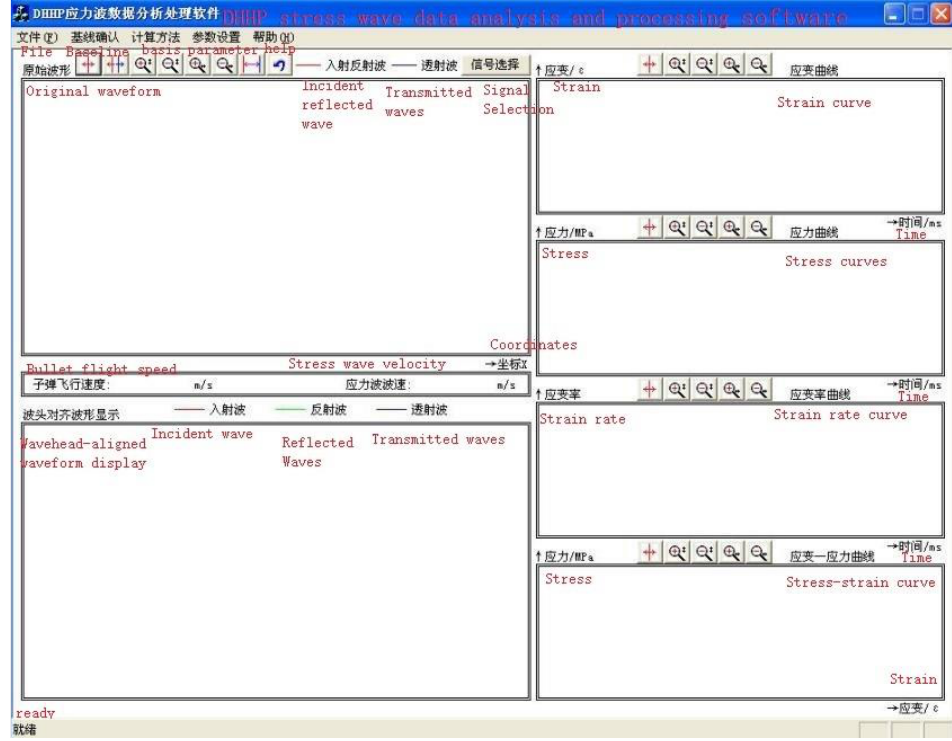
Figure 11. Stress wave data analysis and processing software.